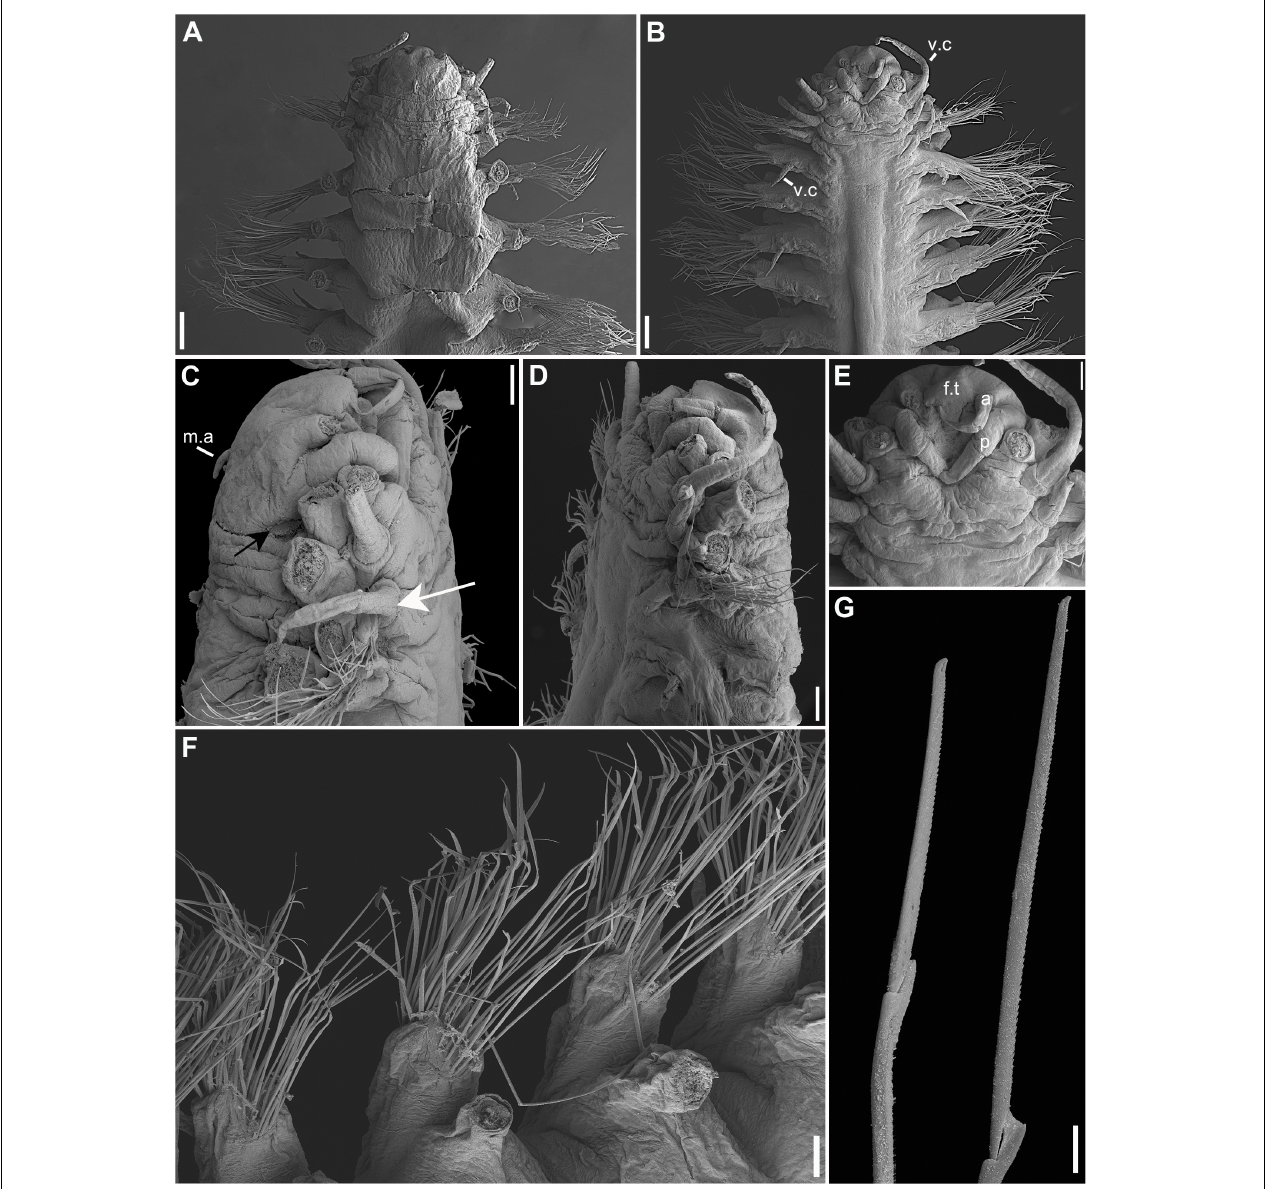
FIGURE 5 | (A–G) Sirsoe sirikos . (A) anterior end, dorsal view; (B) anterior end, ventral view; (C,D) anterior end, lateral view; (E) detail of anterior end, ventral view; (F) median neuropodia; (G) supra- and sub-acicular neurochaetae. a, lateral antenna; f.t., frontal tubercle; m.a, median antenna; p, palps; v.c., ventral cirri; white arrow on C: indicate neuropodial lobe on 3rd segment; black arrow on C: indicate small-depression-like nuchal organs. Scales: (A,B) 200 µ m; (C,G) 100 µ m.